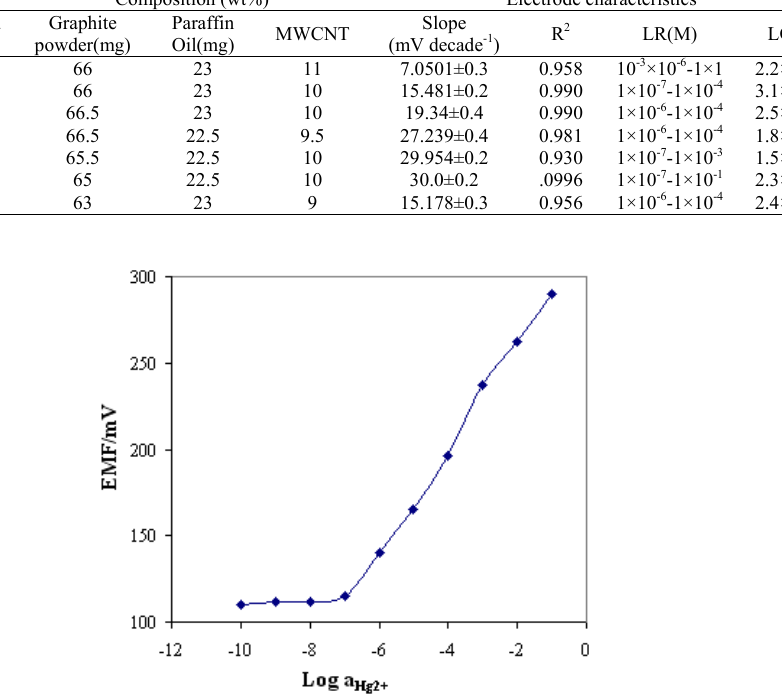
Fig. 4. The calibration curve of the Hg 2+ electrode (composition no. 6) based on the 3-((3-mercaptophenyl) aminomethyl)benzene-1,2-diol.